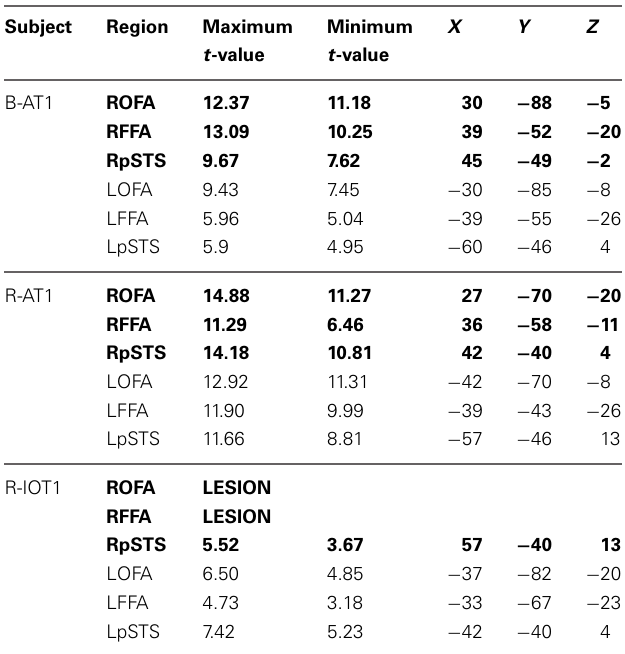
Table 2 | Results of the dynamic functional localizer, with brains standardized to Talairach